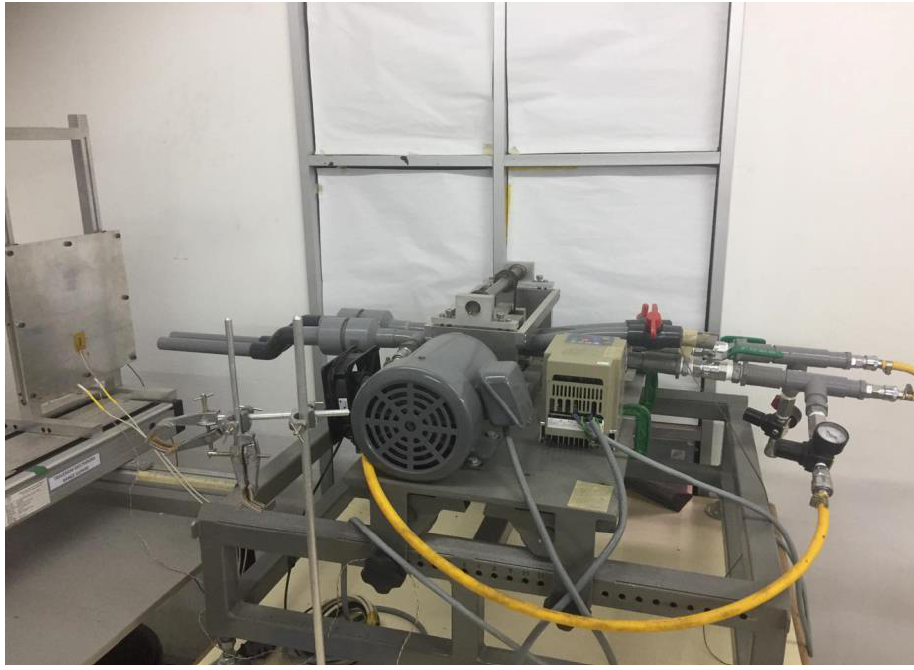
Figure 3. Twin jet impingement mechanism and heat flux microsensor on the aluminum impinge- ment surface. Figure 1. Schematic of twin impingement jets tests setup.